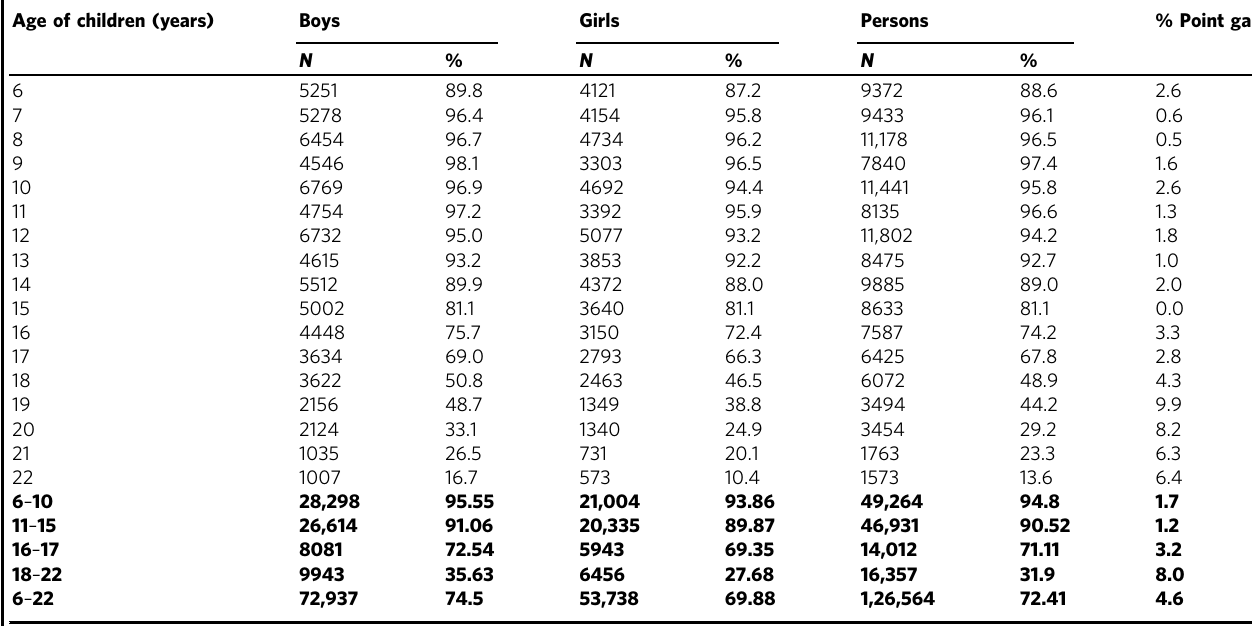
Table 2 Percentage of children attending school by sex and age (2017 – 18), India. Age of children (years) Boys Girls Persons